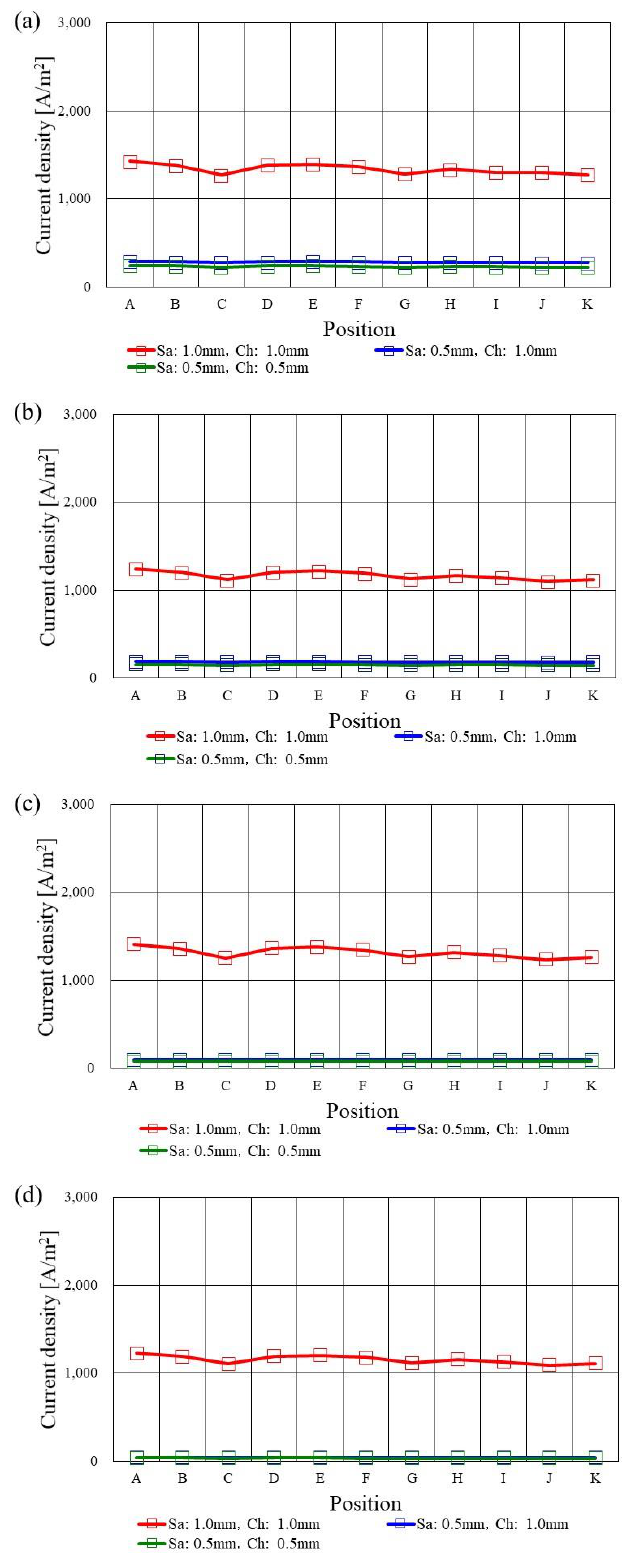
Figure 13. Current density along with the gas channel on the interface between PEM and catalyst layer at the cathode among various s.t. at T ini = 373 K. ( a ) A80%RH/C80%RH, ( b ) A80%RH/C40%RH,